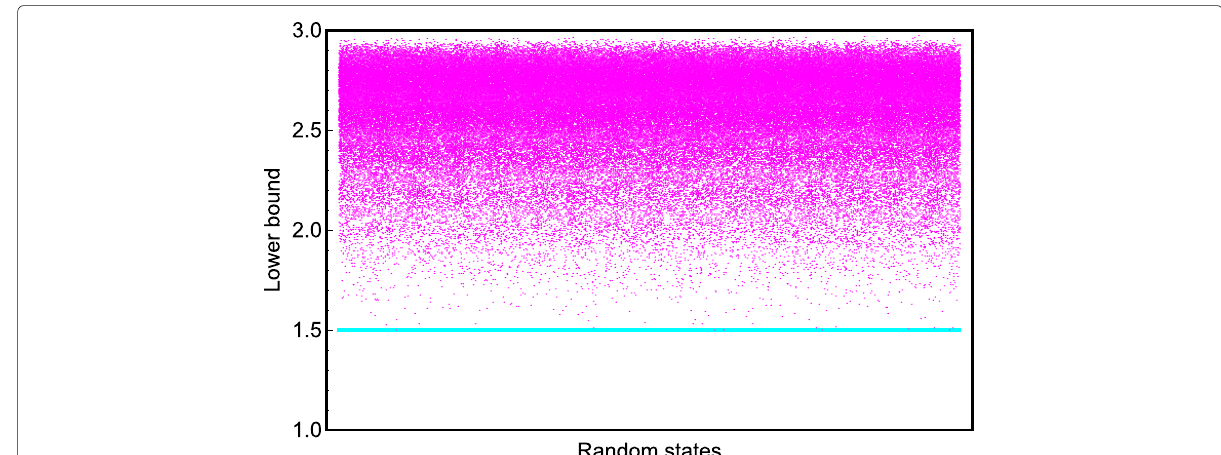
Fig. 4 Our lower bound in comparison with Renes-Boileau’s bound with respect to 1.5 10 5 four-qubit random states. The X-axis is denoted as randomly generated four-qubit states, and the Y-axis denotes the magnitude of our lower bound in Eq. (15), and the cyan line represents Renes-Boileau’s bound in Eq.